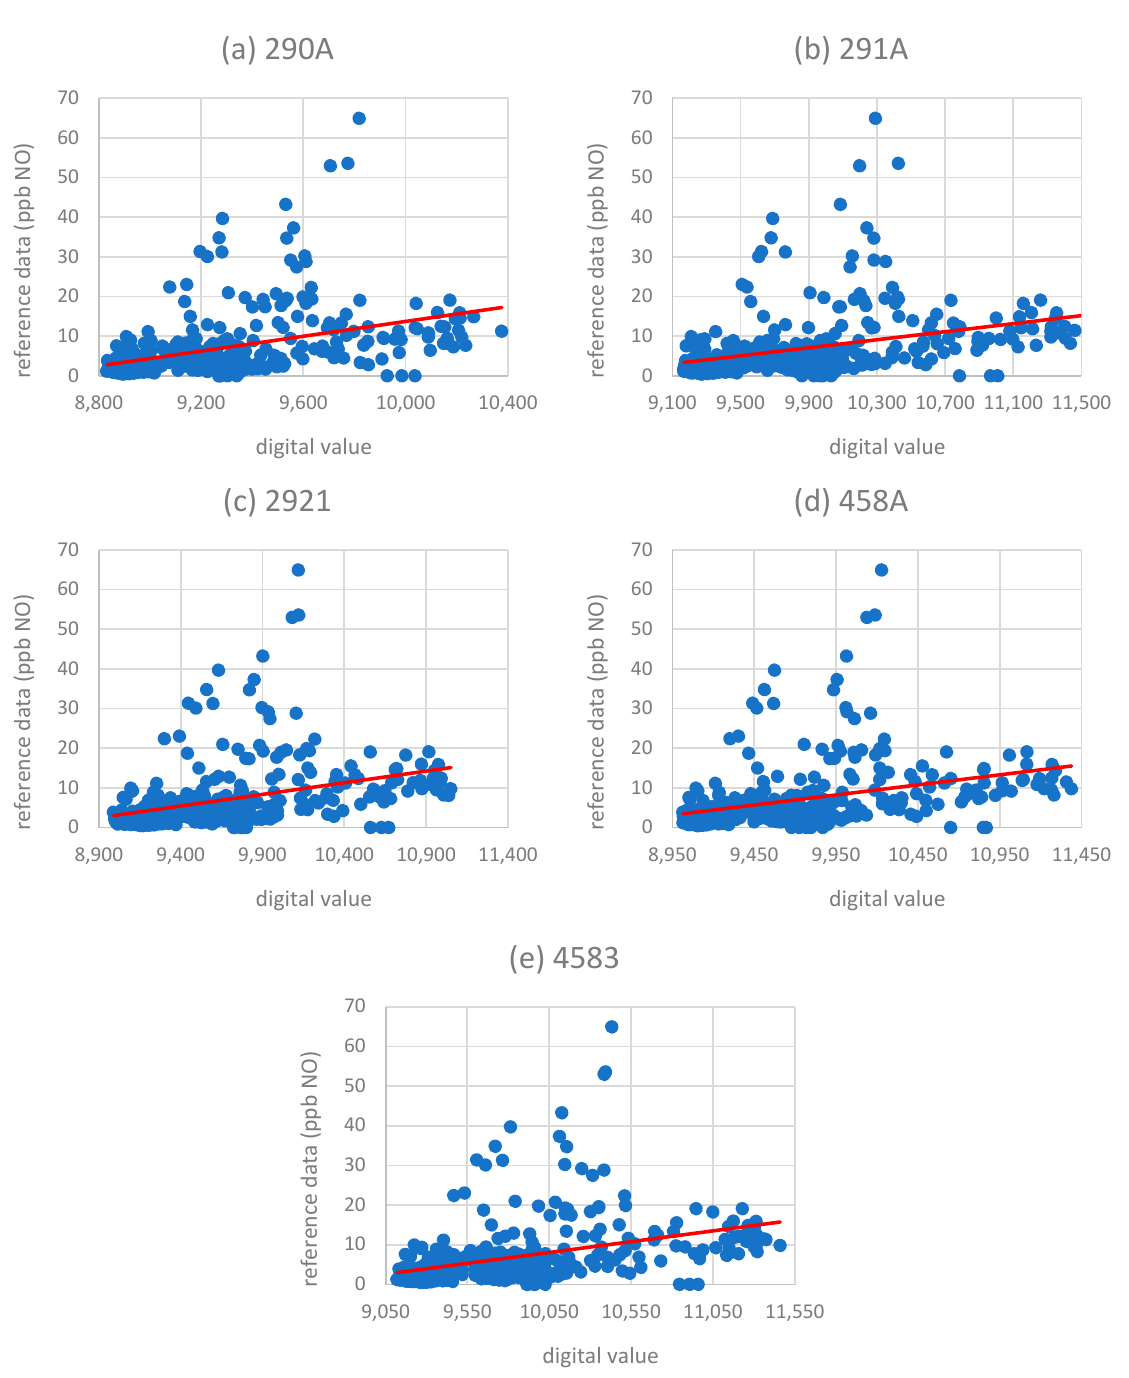
Figure 2. ( a – e ) Plotted data points (blue dots) and trend line (red) for the examined NO sensors.